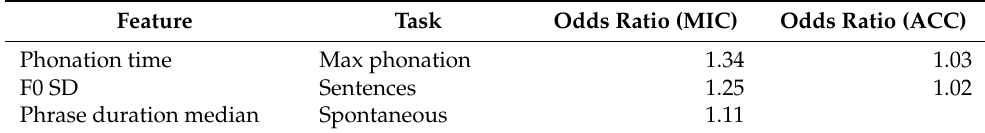
Table 3. Feature weights and odds ratios for the MPT+ model.